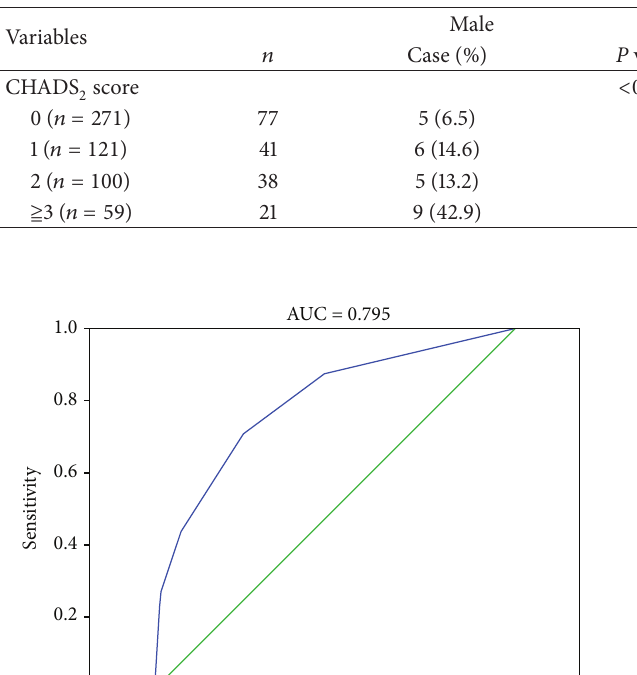
scores from 2002 to 2009 ( 𝑛 = 551 ). 2